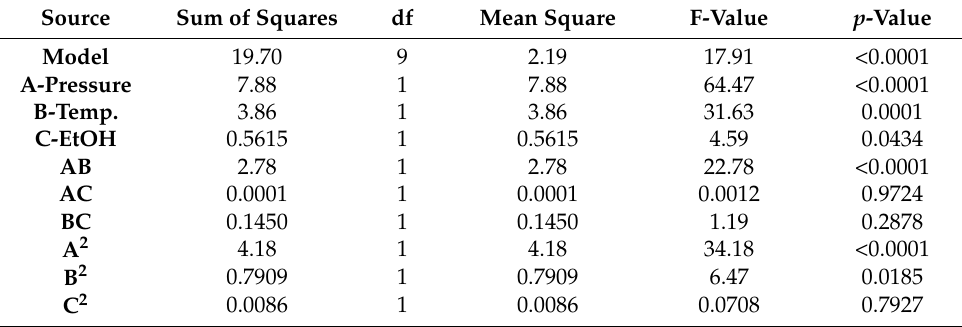
Table 3. Analysis of variance (ANOVA) for MRSA with quadratic